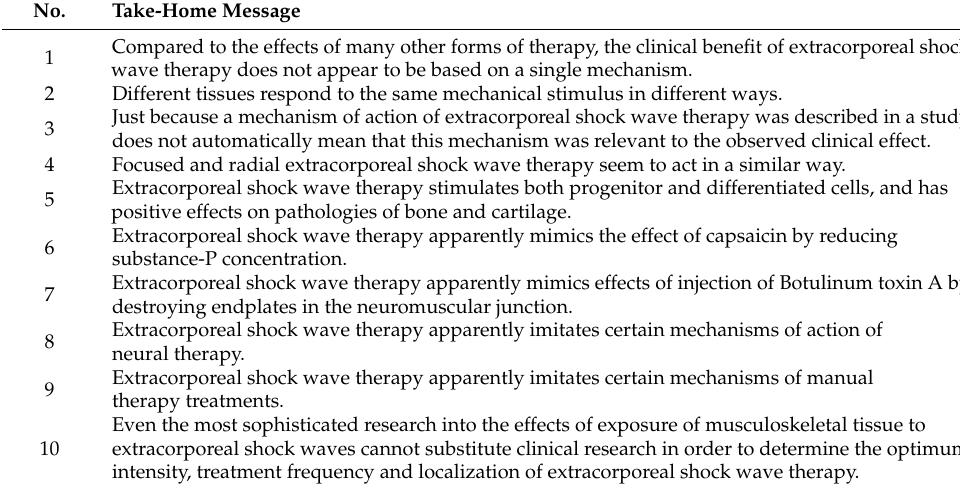
Table 4. Take-home messages regarding the effects of exposure of musculoskeletal tissue to extracor- poreal shock